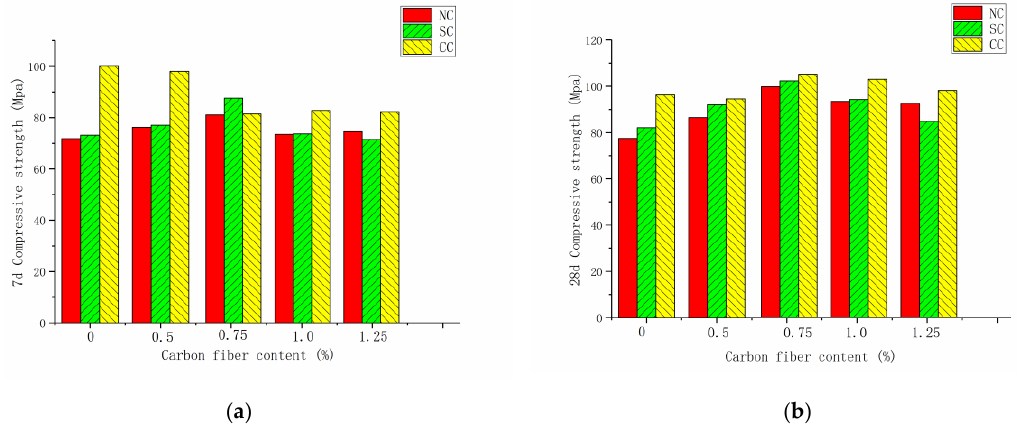
Figure 4. Compressive strength under different curing systems at seven days and 28 days: ( a ) seven days, ( b ) 28 days.